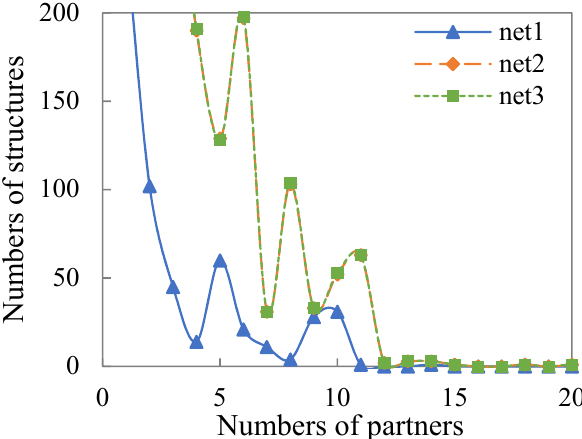
Figure 5. The number of GWESP (geometrically weighted edgewise shared partners).